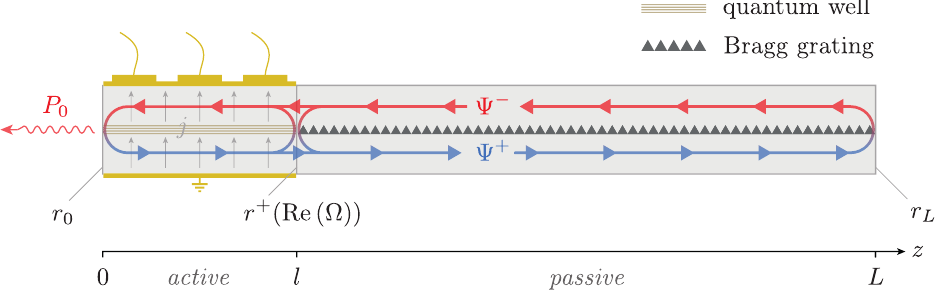
Figure 2. Schematic illustration of a two-section DBR laser featuring an active gain section and a passive Bragg grating as considered in Section